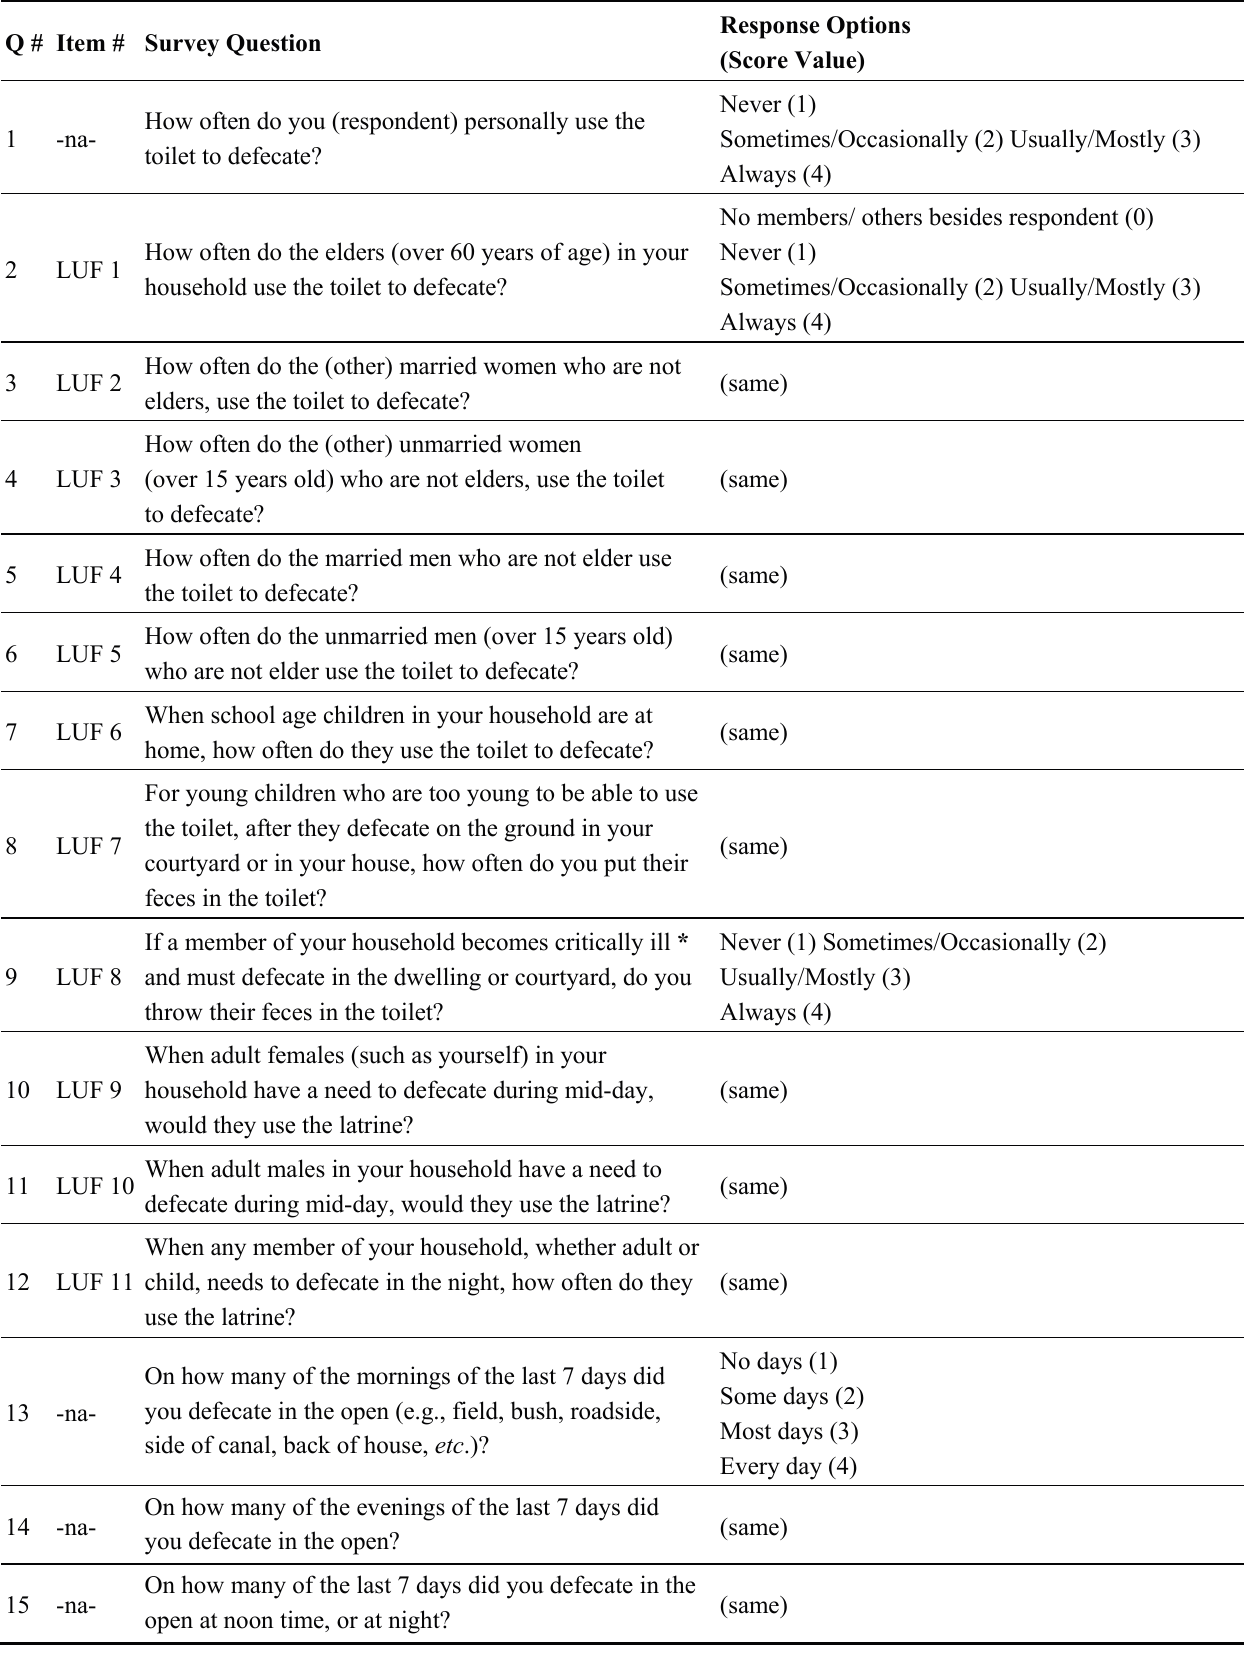
Table 1. Safe San Index items, scoring, and